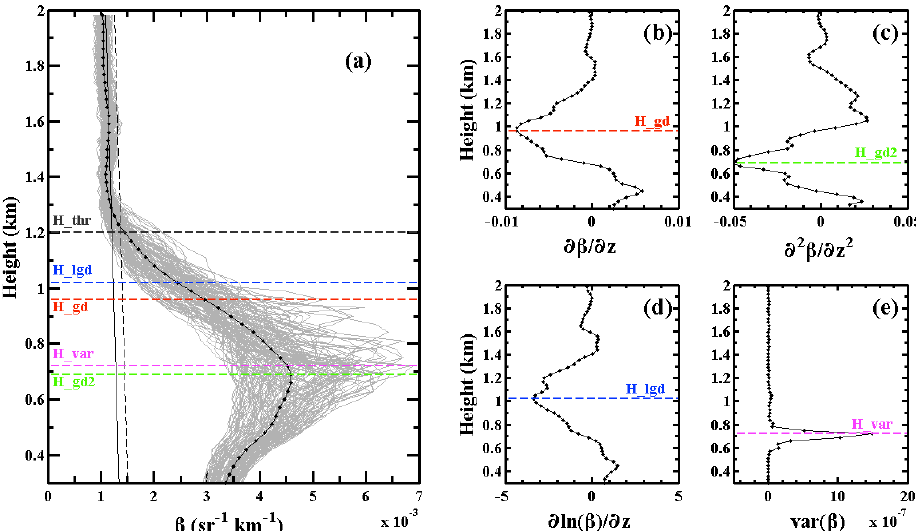
Figure 1. Comparison of BLH determinations from lidar measurements with five different methods. 𝜷 denotes the lidar backscatter intensity (sr -1 km -1 ). (a) Comparing of BLH derived from different methods. The gray lines are the measured 30s-averaged 𝜷 within 1-hour centered at 4:30pm June 24,2007 at the continental site . The black dotted line is the averaged 𝜷 of all gray lines. H_thr denotes the BLH derived by the threshold method; H_gd denotes the BLH derived by the gradient or derivation method (b) ; H_gd2 denotes the BLH derived by the second derivation method (c) ; H_lgd denotes the BLH derived by the log-gradient method (d) ; H_var denotes the BLH derived by the variance (var) method (e) using the data shown as the gray lines in (a)